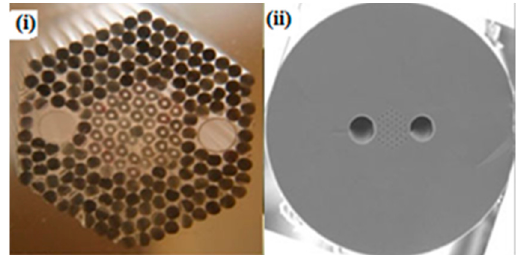
Figure 24. Image of two large air holes consisting PCF; cross-section of ( i ) the preform and ( ii ) fabricated high-birefringent fiber. It is used for the demonstration of a curvature sensor (Reproduced from [85], with the permission of IOP Science publishing).